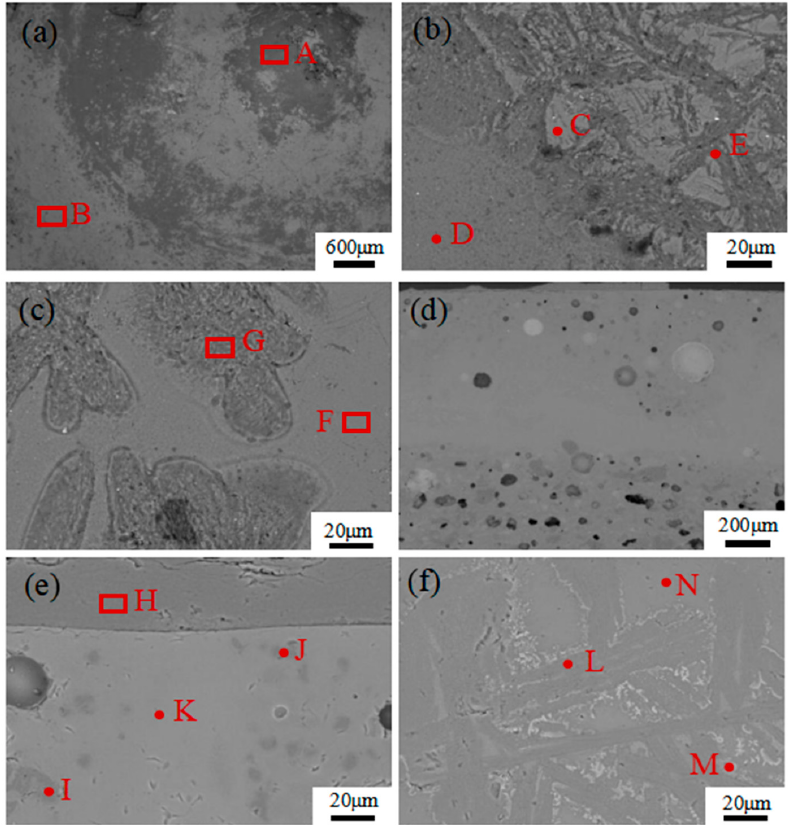
Figure 8. SEM images of pearl-glazed porcelain (JZ-14) with di ff erent magni fi cation: ( a – c ) surface morphology; and ( d – f ) the polished cross-section morphology.